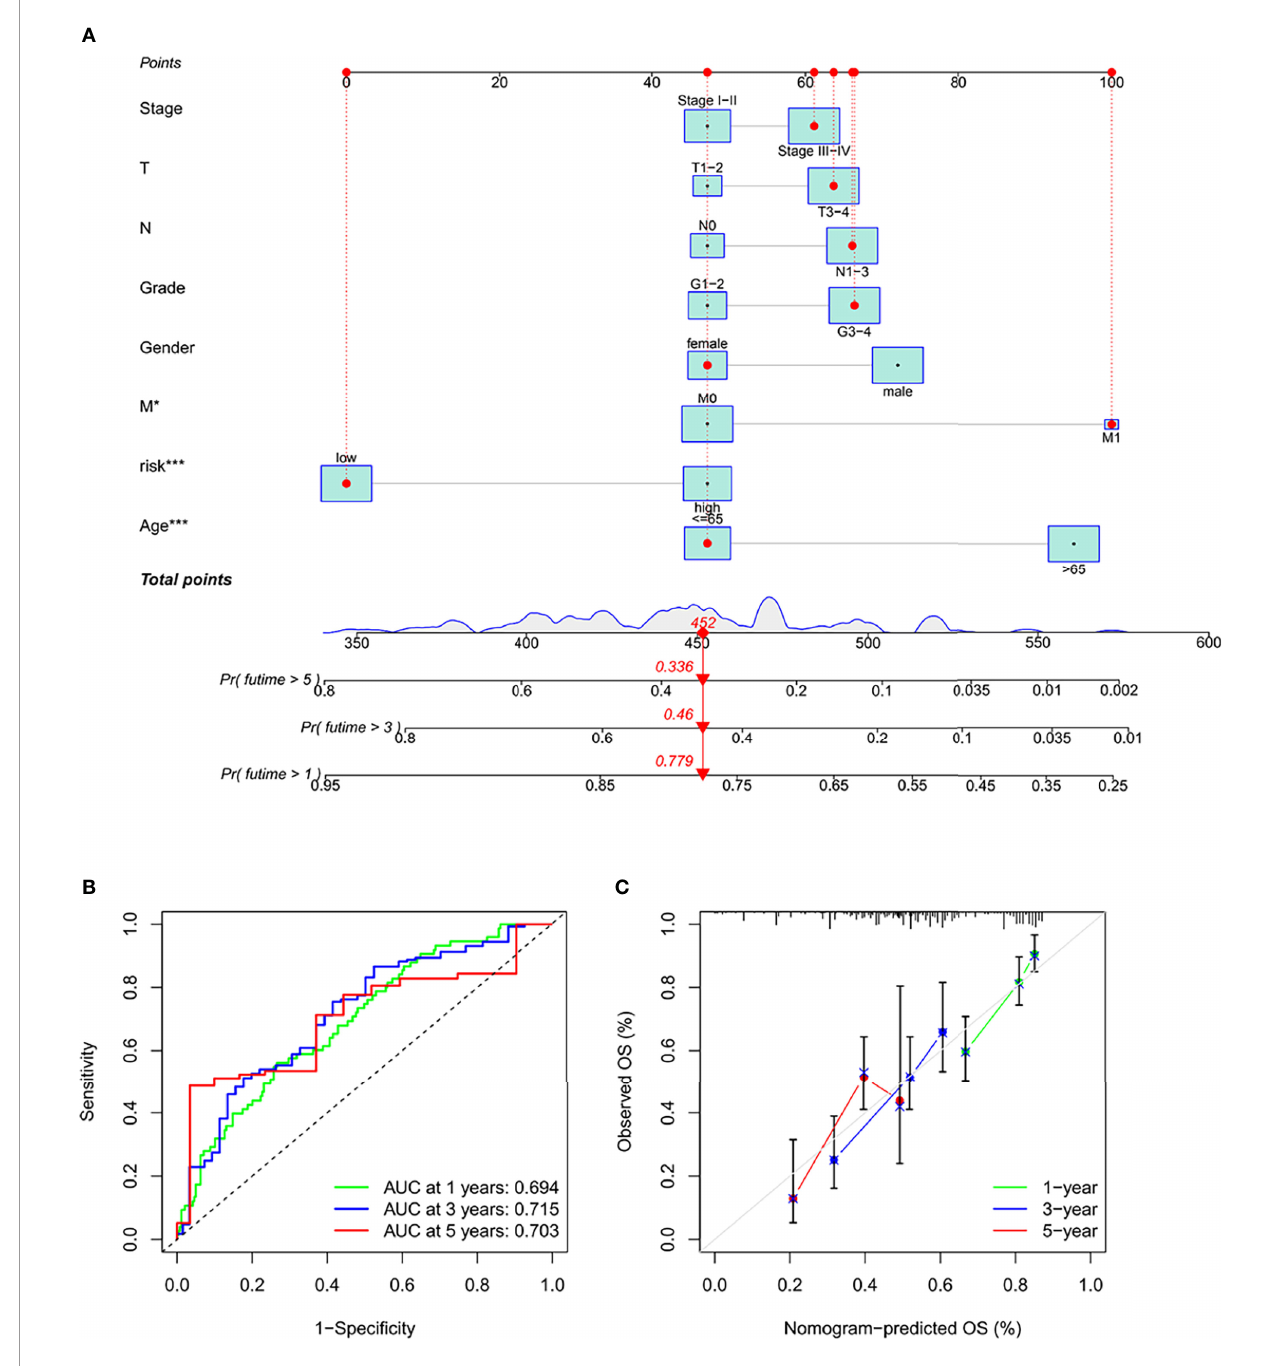
FIGURE 6 | Construction and validation of a columnar chart. (A) Survival columnar charts based on the total TCGA cohort. (B) The ROC curve compares the prognostic ability of columnar charts in the TCGA cohort at 1, 3, and 5 years. (C) Calibration curves to predict 1, 3, and 5-year survival in STAD patients in the TCGA cohort. *p < 0.05. ***p <